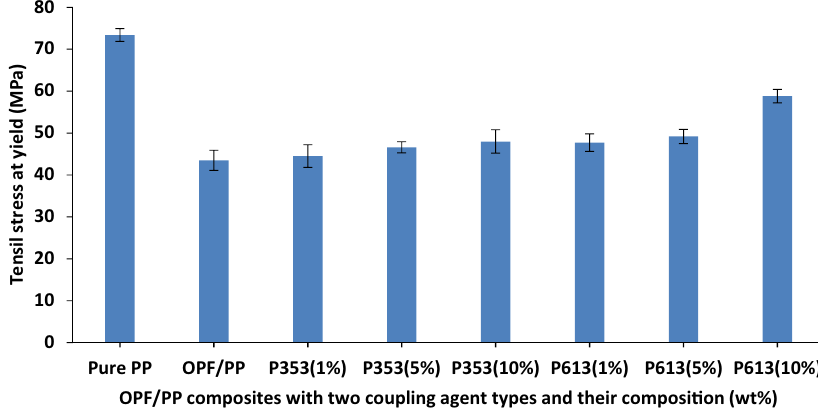
Figure 2: Tensile stress at yield of the pure PP, uncoupled, and coupled 20% OPF/PP polymer composite with two coupling agent types of di ff erent weight percentages.